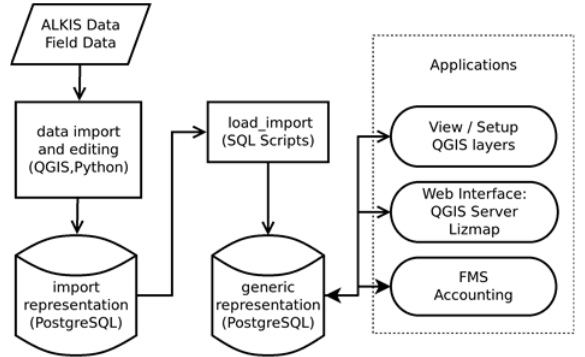
Figure 3 : Components of the integration workflow For each city/community the basic geometries of parcels, buildings and streets are set up and stored in the PostgreSQL database using the corresponding ALKIS dataset. Additional data are supplied using QGIS (see also section 2.2). The import representation corresponds to one schema per project /community that contains a fixed set of tables for different types of objects (parcels, buildings, other areas, lines, points) with columns for all properties of the respective